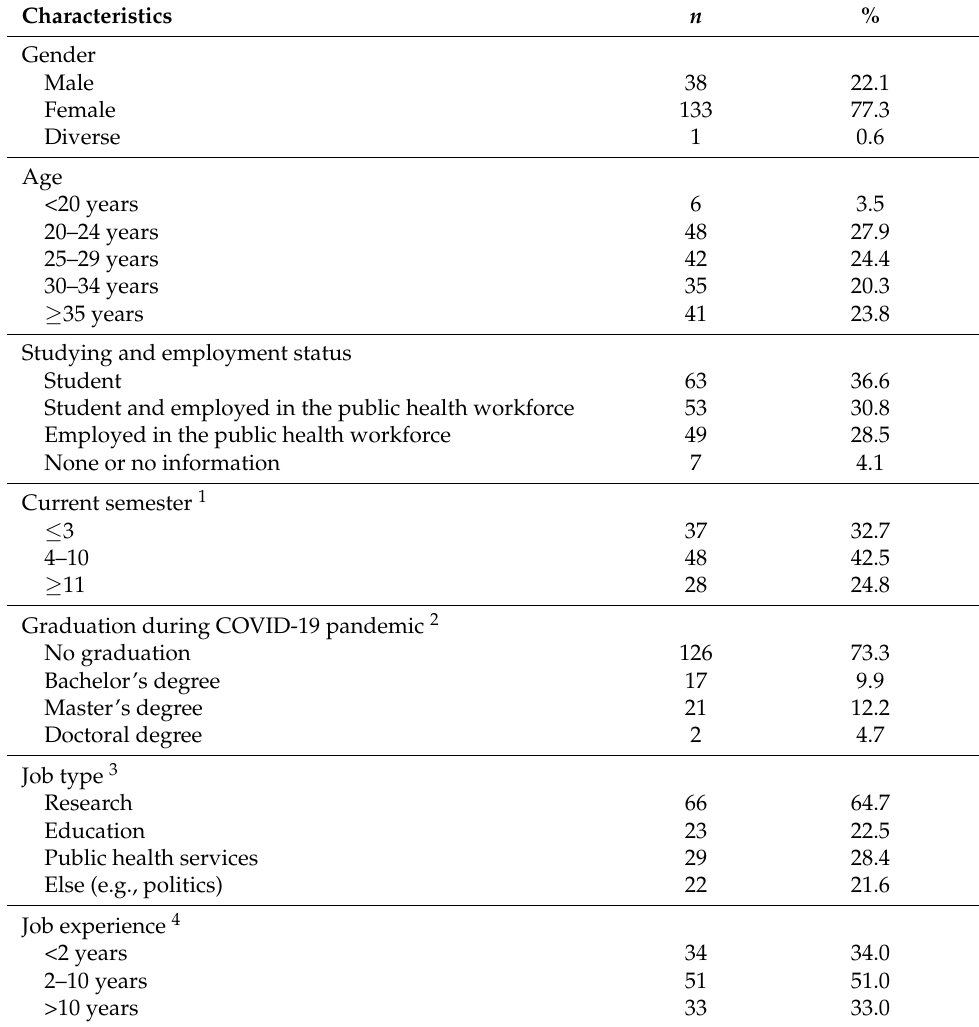
Table 3. Characteristics of study participants ( n =